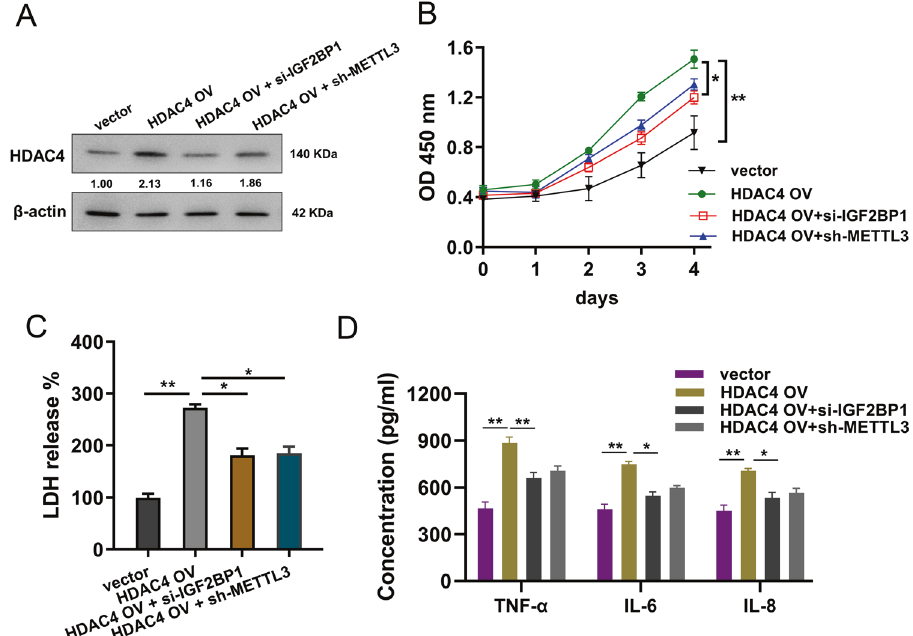
Fig. 5 METTL3/IGF2BP1/HDAC4 axis regulates the in fl ammatory damage of cardiomyocytes induced by LPS. A Western blot analysis detected the HDAC4 protein level in cardiomyocytes (H9C2) transfected with HDAC4 overexpression (HDAC4 OV) or IGF2BP1 knockdown (si- IGF2BP1) or METTL3 knockdown (sh-METTL3) respectively. B CCK-8 analysis was performed to detect the proliferative ability of cardiomyocytes. C ELISA analysis detected the levels of proin fl ammatory cytokines, including interleukin (IL)-6, IL-8, and tumor necrosis